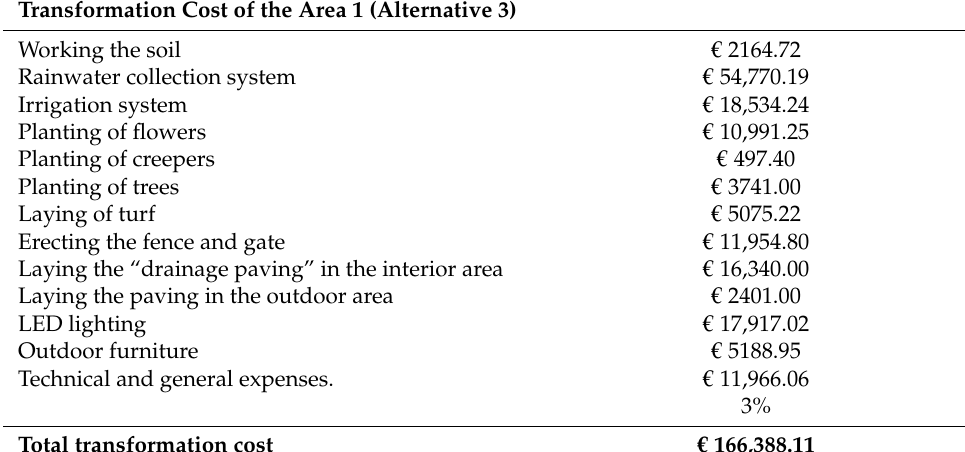
Table 4. Transformation costs of Area